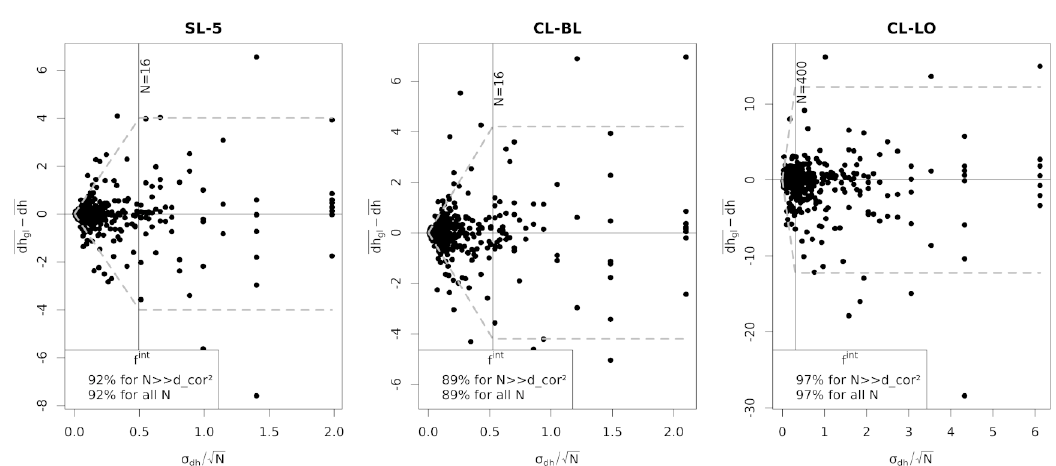
√ (cid:16) (cid:17) Figure 7. Scatter plot of ((cid:1856)ℎ (cid:3034)(cid:3039) (cid:3364)(cid:3364)(cid:3364)(cid:3364)(cid:3364)(cid:3364) − (cid:1856)ℎ(cid:3364)(cid:3364)(cid:3364)(cid:3364)) versus (cid:2026) (cid:3031)(cid:3035) √(cid:1840)⁄ for the three tested void filling approaches. dh gl − dh N for the three tested void filling approaches. Figure 7. Scatter plot of versus σ dh / Black vertical lines indicate correlation area approximation in pixels ( (cid:1856) (cid:3030)(cid:3042)(cid:3045)(cid:2870) ). Gray dashed lines indicate Black vertical lines indicate correlation area approximation in pixels ( d 2 cor ). Gray dashed lines indicate √ the bounds from Equations (16) and (18) approximated by 2(cid:1856) (cid:3030)(cid:3042)(cid:3045) (cid:2026) (cid:3031)(cid:3035) √(cid:1840)⁄ for (cid:1840) > (cid:1856) (cid:3030)(cid:3042)(cid:3045)(cid:2870) and by 2(cid:2026) (cid:3031)(cid:3035) N for N > d 2 cor and by 2 σ dh for the bounds from Equations (16) and (18) approximated by 2 d cor σ dh / for (cid:1840) < (cid:1856) (cid:3030)(cid:3042)(cid:3045)(cid:2870) . (cid:1858) int : fraction of points within the bounds. N < d 2 cor . f int : fraction of points within the bounds.